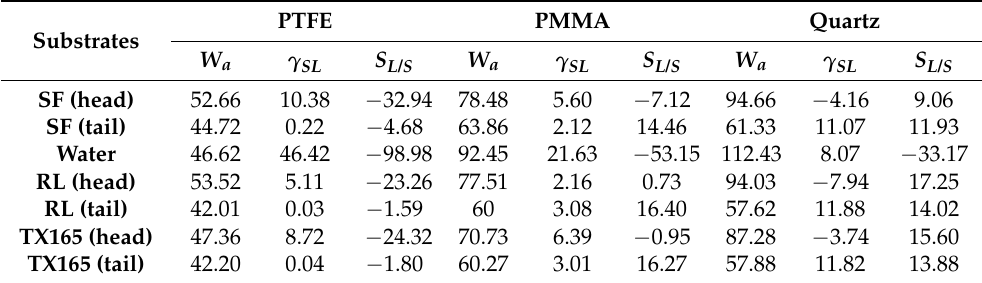
Table 2. The values of adhesion work ( W a ), solid-liquid interface tension ( γ SL ) calculated from Equations (1) and (2), respectively and the values of spreading coefficient ( S L / S ). PTFE PMMA Quartz Substrates W a γ SL S L / S W a γ SL S L / S W a γ SL S L / S SF (head)